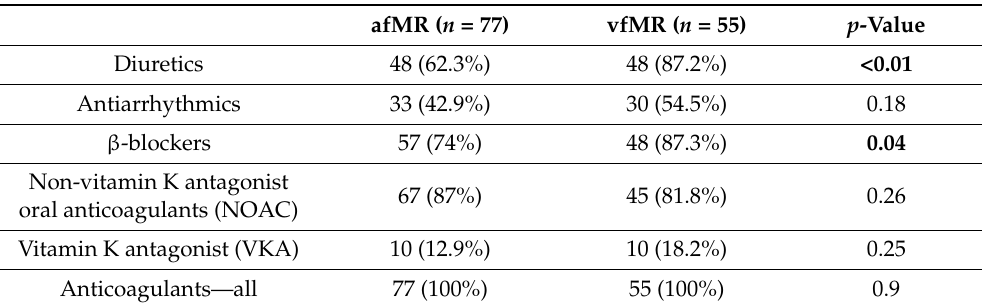
Table 4. Comparisons of drugs used during hospitalization between groups of patients with afMR and vfMR.